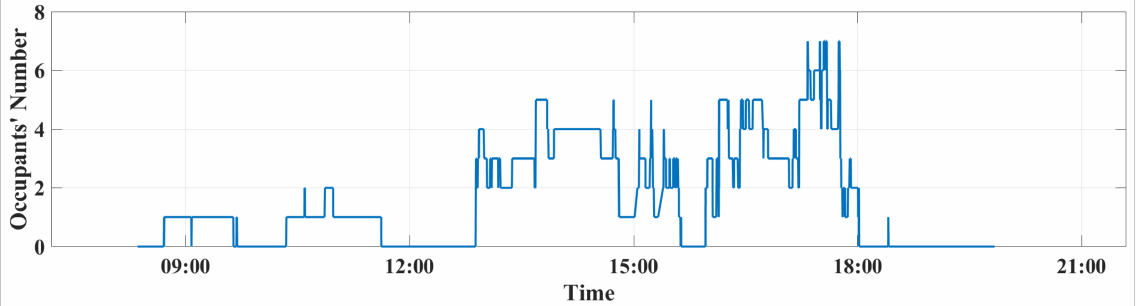
Figure 7. Occupants’ numbers over the day in